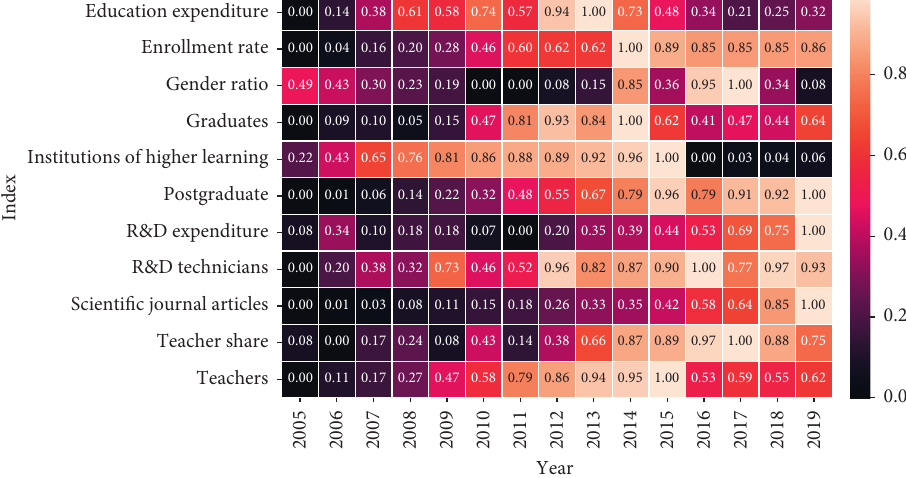
Figure 6: Vietnam higher education index heat